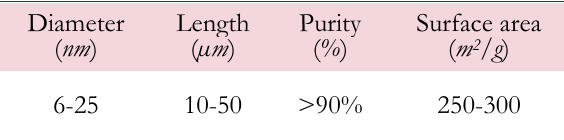
Table 1: Physical characteristics of MWCNTs.